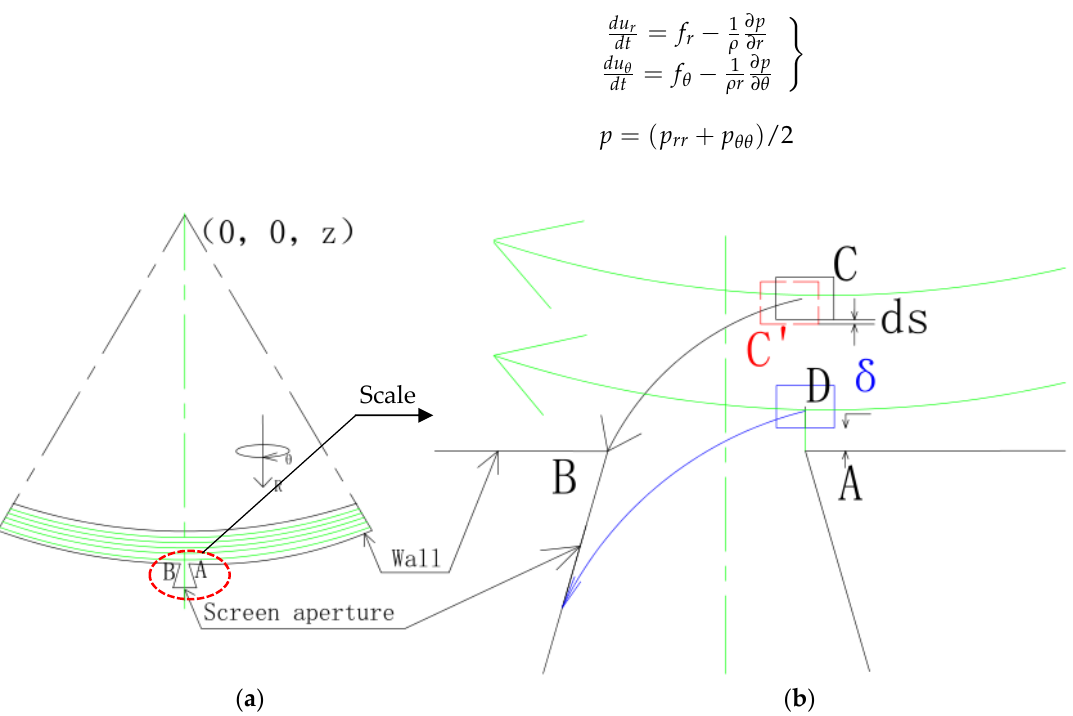
Figure 3. Schematic diagram of the fluid passing through the screen in the cylindrical coordinate system ( a ) 2D plane flow and ( b ) scale.